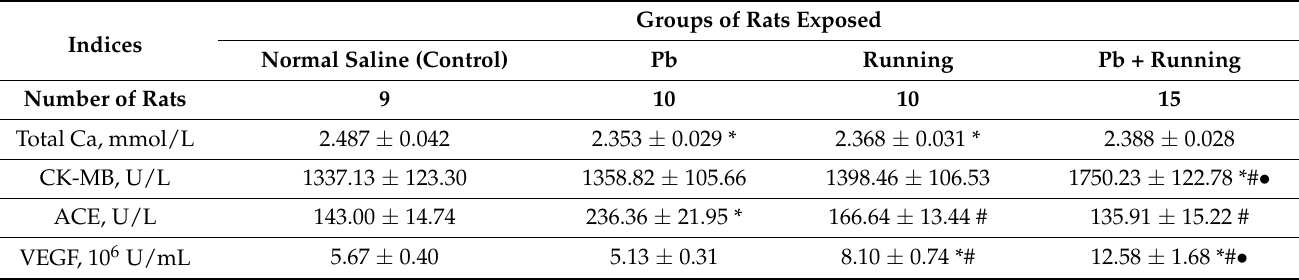
Table 1. Some biochemical indices of rat’s blood serum in the experiment.